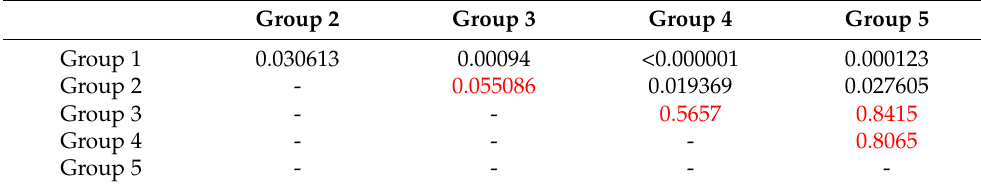
Table 5. Comparison of groups with the Chi-squared test. Values for which there were no statistically significant differences are highlighted in